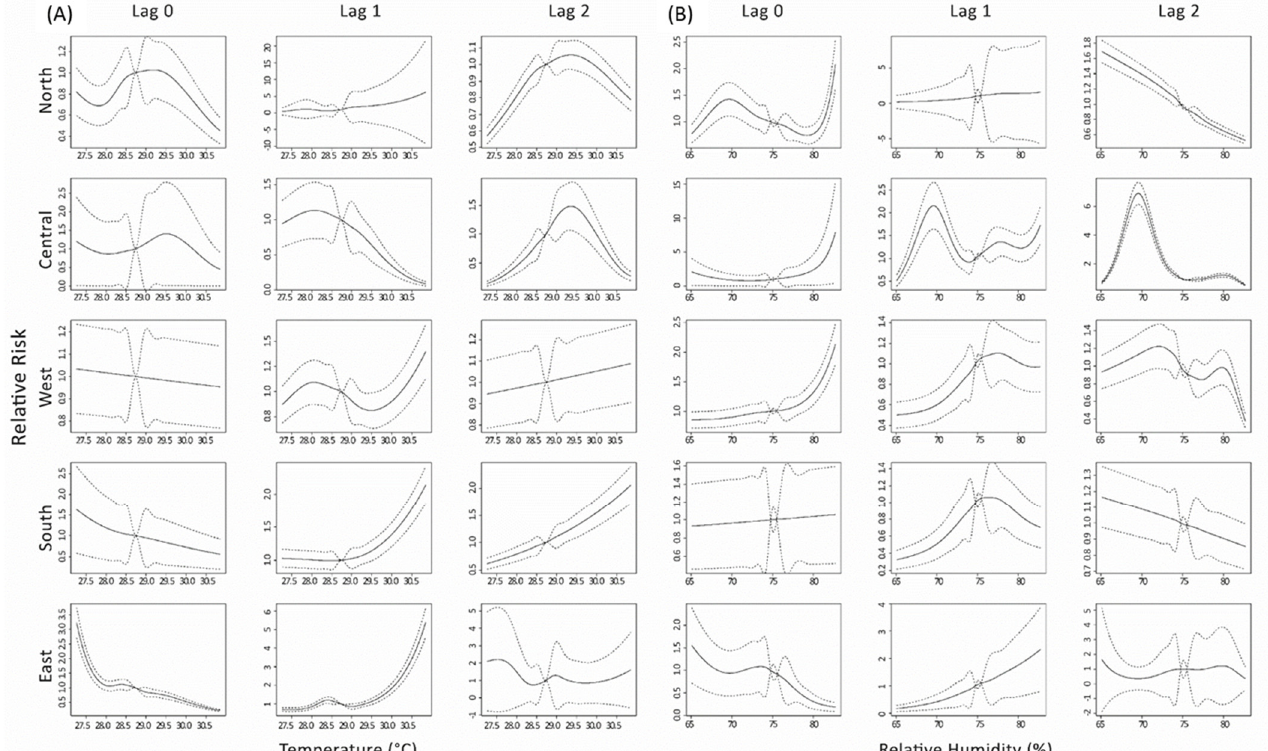
Figure 4. Lag associations between the relative risk of diarrhea and monthly ( A ) average tempera ‐ ture (°C), and ( B ) relative humidity (%) in Surabaya from January 2018 to September 2020. ( ◦ C), and ( B ) relative humidity (%) in Surabaya from January 2018 to September